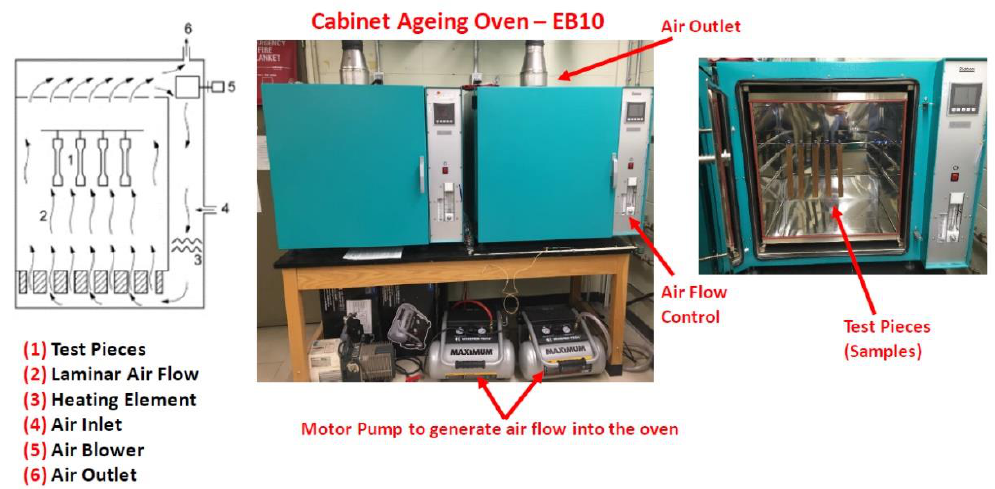
Figure 2. Schematic representation of the air flow ( left ), ageing oven ( middle ), specimens during ageing testing ( right ).